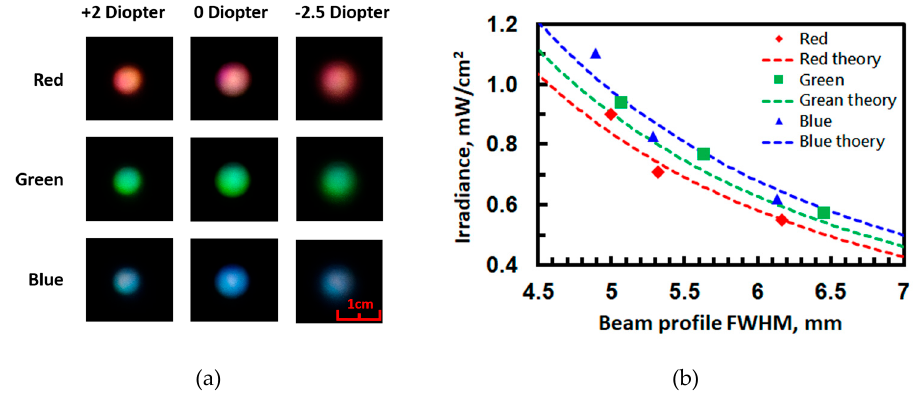
Figure 21. ( a ) Beam spots at di ff erent lens powers for di ff erent transmissive color modes. ( b ) Irradiance as a function of beam diameter at di ff erent modes.